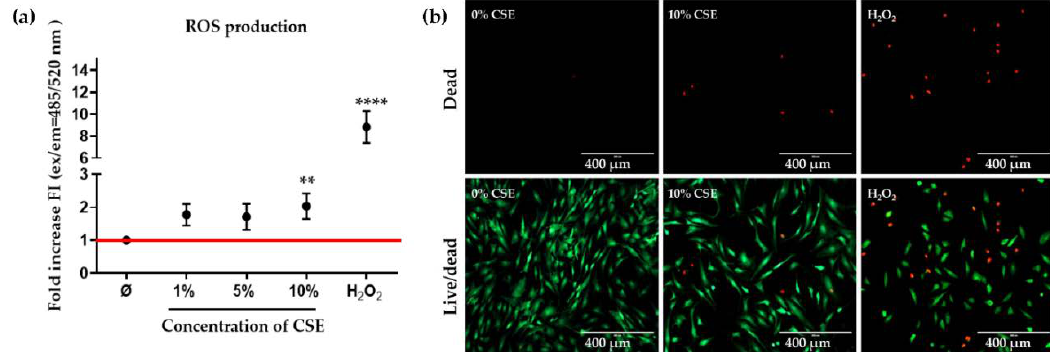
4 of 17 Figure 2. CSE exposure decreased the matrix formation of human primary chondrocytes. Cells ( N = 3, n = 3) were cultured in a medium containing 0%, 0.1%, 0.5%, 1%, 5%, and 10% CSE. Matrix formation was determined quantitatively by resolving Alcian blue staining after growing in the medium with or without CSE for 7 ( a ) and 14 days ( b ), respectively. ( c , d ) Representative Alcian blue and Safranin-O stainings are shown to visualize matrix formation on day 7. Results are given as fold of control (untreated cells) and presented as mean ± SEM. ** p < 0.01, *** p < 0.001 as compared to untreated cells. 2.2. CSE Exposure Induced Cell Death by Increasing ROS Production It is well known that ROS are chemical constituents of cigarette smoke that are crucial to produce adverse effects in humans [16]. Compelling studies have indicated that chondrocyte cell death occurs and contributes to OA development and that ROS are among the main factors that induce cell death